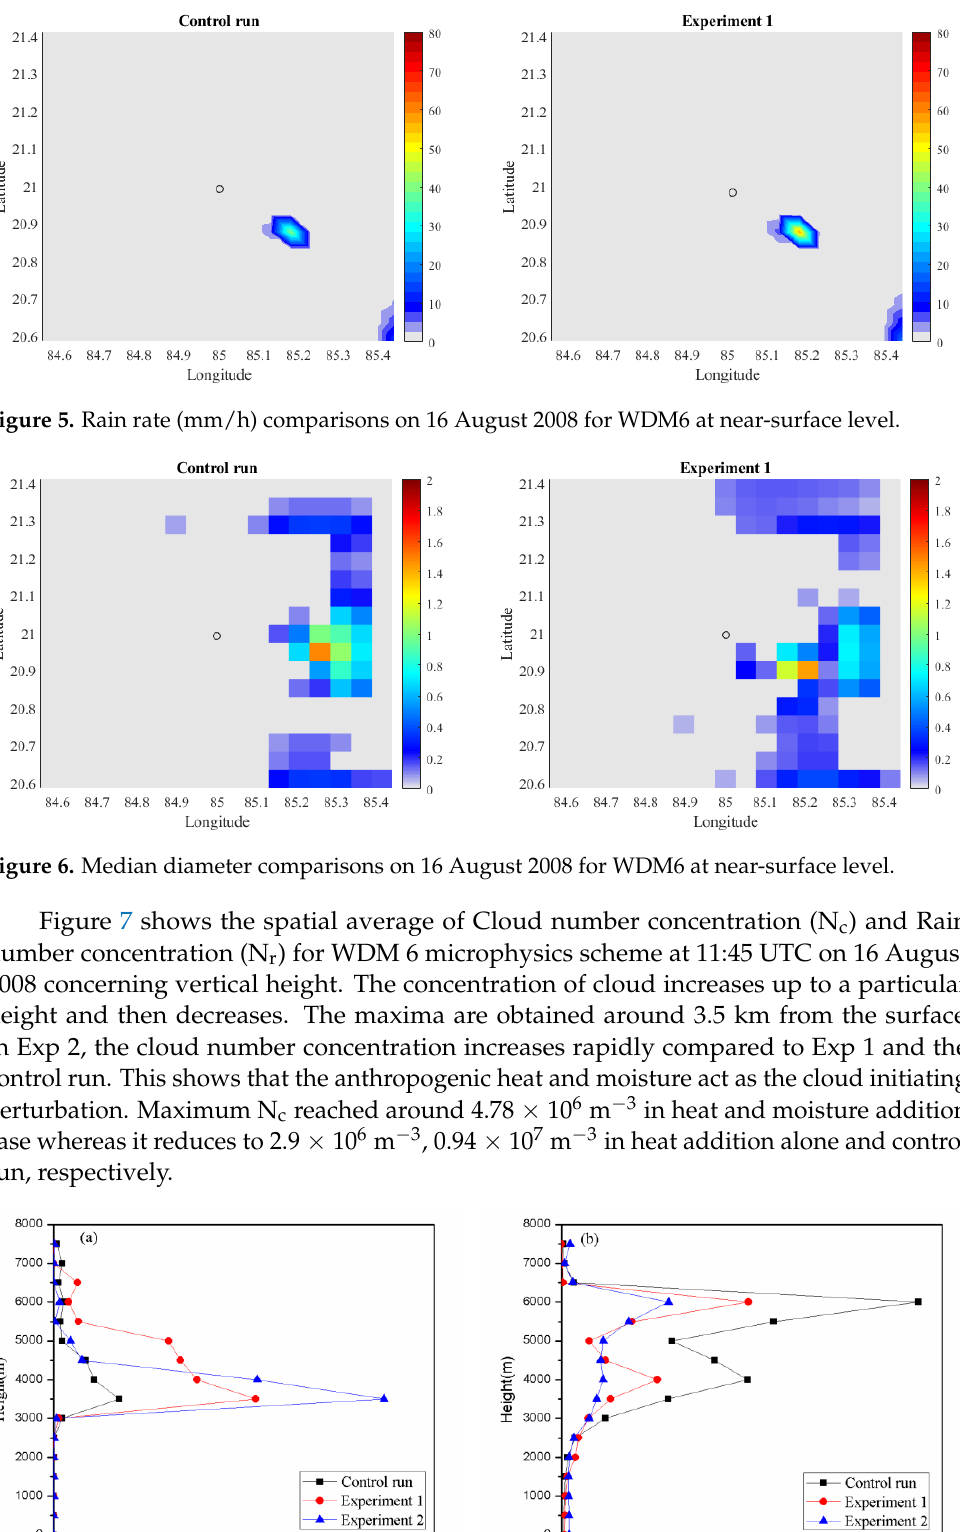
is more pronounced when moisture is released [56].